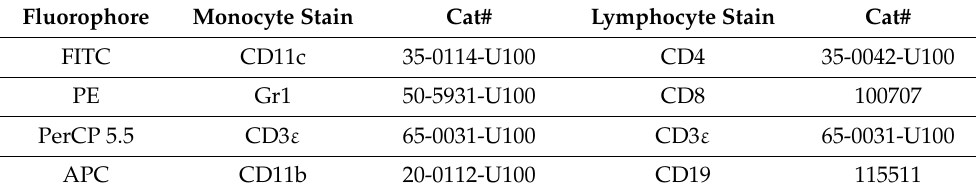
Table 1. Fluorescent antibodies used for FACS staining in preparation for flow